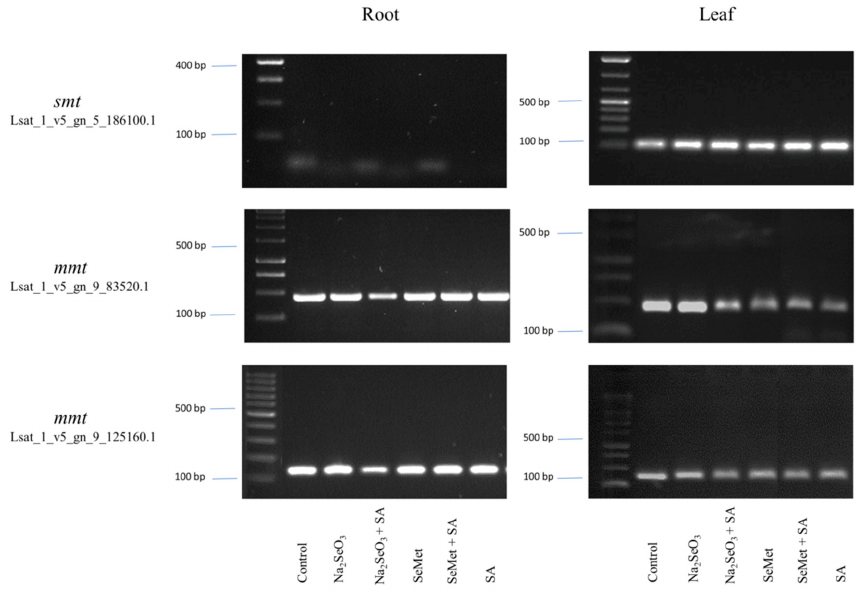
Figure 4. Confirmation of the specificity of primers and amplicon sizes for smt and mmt genes based on gel electrophoresis of RT-PCR products. M: 1 kB ladder. See Table 1 for product sizes.